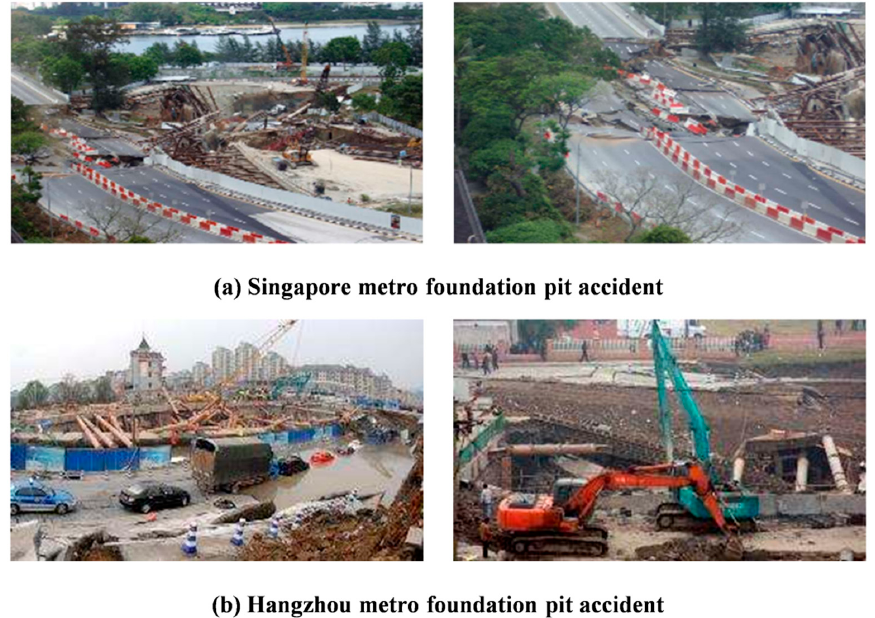
Figure 6. Metro foundation pit accident.